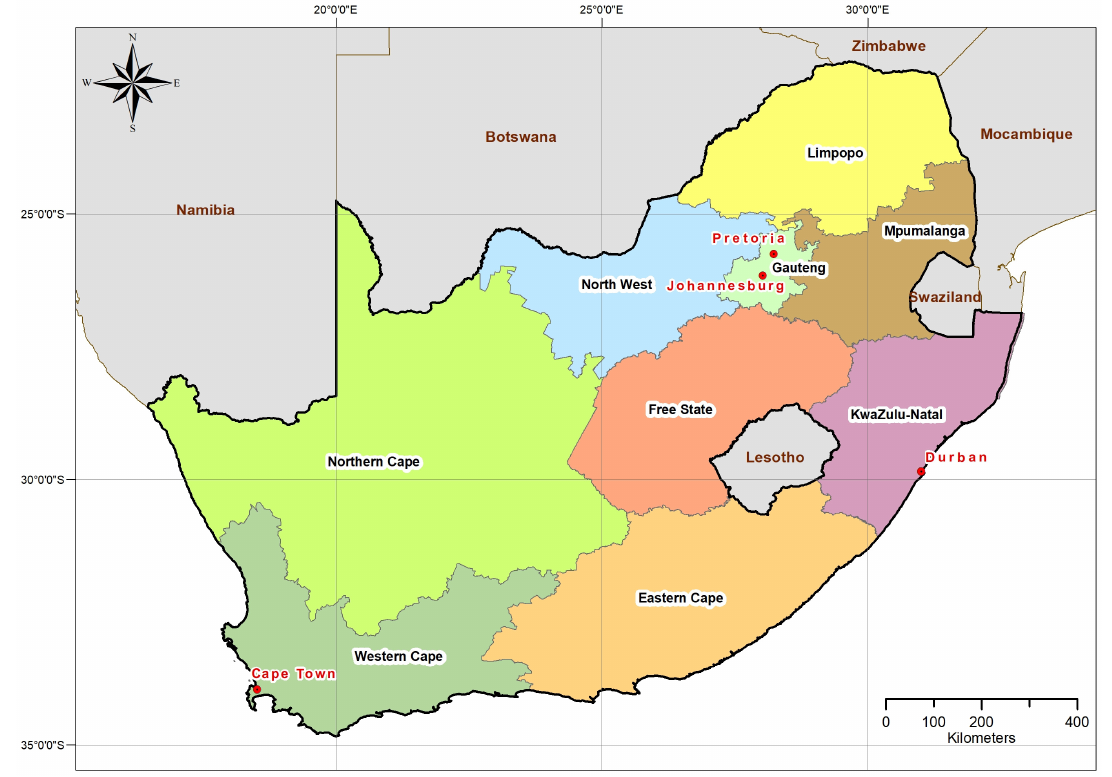
Figure 1. The Provinces and four largest cities of South Africa (Map produced by T Kapwata). South Africa’s multi-ethnic population is officially grouped into Black African, Mixed Ancestry (mixed European [white] and African [black] or Asian ancestry, with skin colour ranging from pale to dark brown), Asian/Indian and White. According to the 2018 mid-year population estimates 81% were Black African, 9% Mixed Ancestry, 8% White, and 2% Indian/Asian [6]. The mid-year population in 2018 was 57.7 million [6].